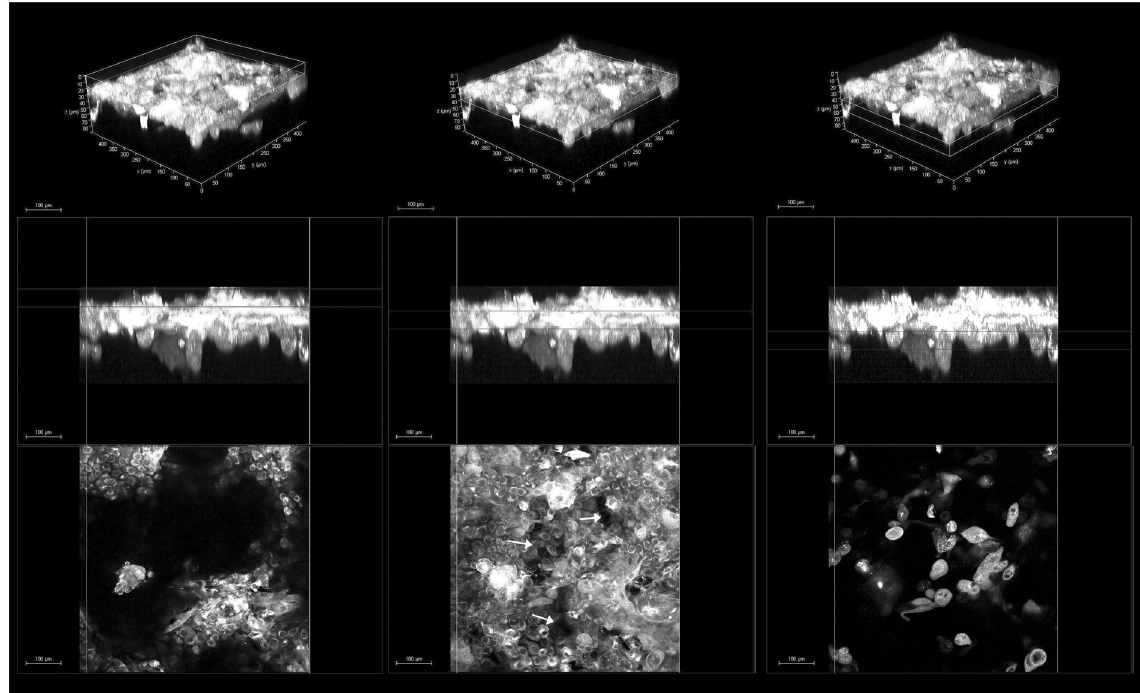
Figure 5. Regenerated epithelium on fibrin gel. (Upper row) 3D reconstruction of the fibrin gel (TPEF signal) with cultivated limbal corneal epithelial cells (scale bar 100 µ m). The white boxes highlight the characteristics of regenerated epithelium, which are shown in the middle (cross-section images) and lower ( enface images) rows at different depths respectively. Middle rows) abnormal stratification of the regenerated epithelium was found in all specimens. (Lower rows) the cells show also variations in shape and size across depth and are not confluent even at the basal plane (arrows). Neither TPEF nor SHG signals could be collected from fibrin